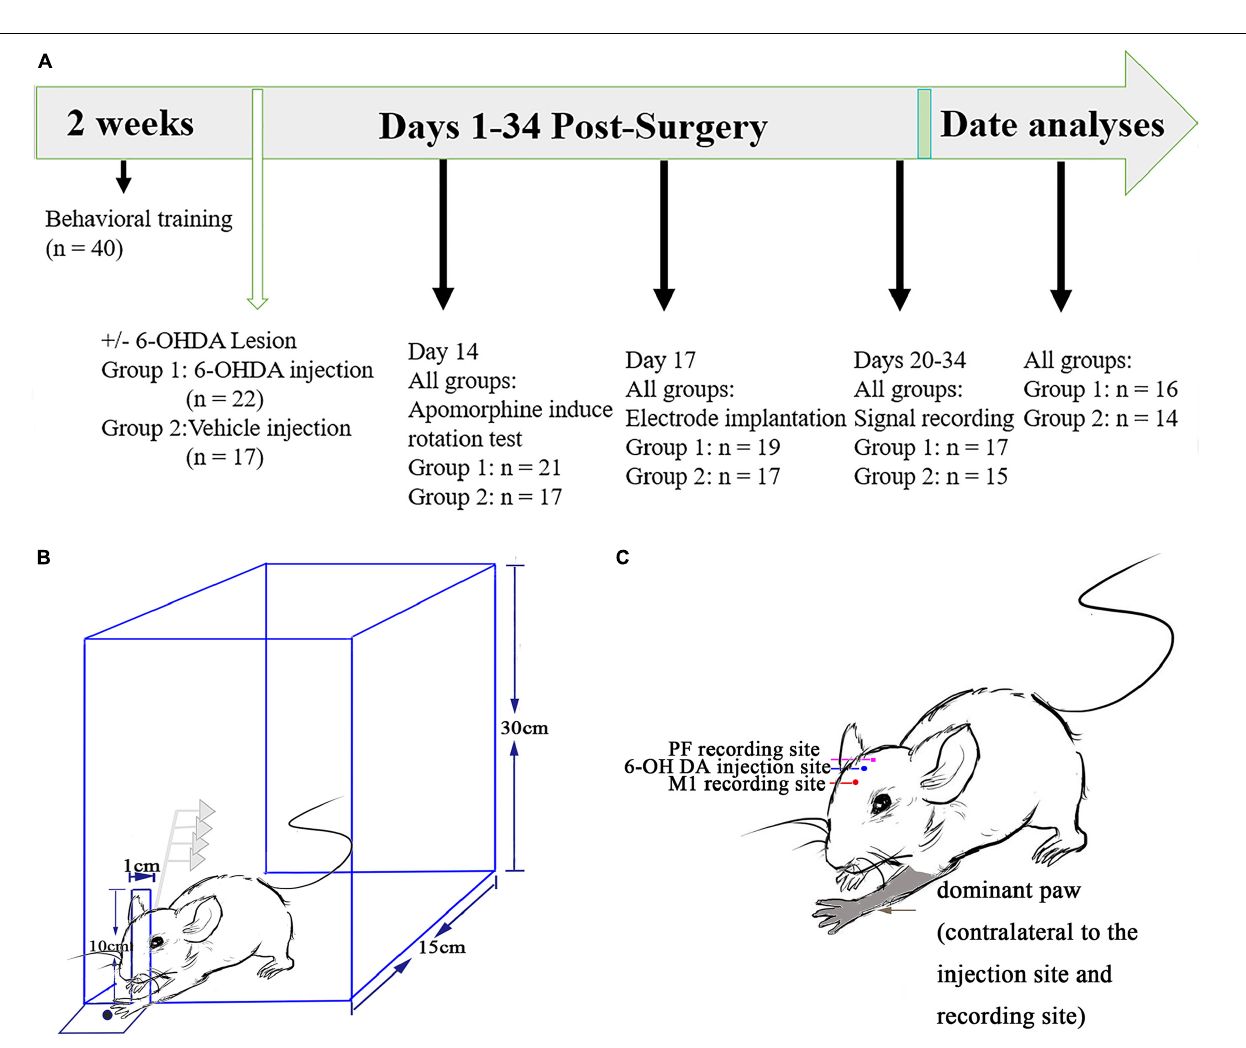
FIGURE 1 | Experimental design and timeline. (A) Prior to and following surgery to induce a unilateral 6-hydroxydopamine (6-OHDA) lesion of the medial forebrain bundle, all rats ( n = 40) underwent behavioral training and were monitored to execute the catching task to obtain food through a slit using their preferred forepaws. All the rats performed an apomorphine-induced rotation test 2 weeks after the surgery. A multiunit recording electrode was implanted into the primary motor cortex (M1) and thalamic parafascicular nucleus (PF) of all the lesioned and control rats 2 weeks after the first surgery. Signal recording began from 20 to 34 days after surgery for further data analyses. (B) Schematic diagram of the multiunit recordings from the M1 and PF nucleus. Slits in the wall of the test chamber were placed individually at the contralateral side of the preferred forepaws. This experiment provides an example indicating that a rat could catch food through a slot with its left forepaw. (C) Illustration showing a rat whose left forepaw dominates after behavioral training. Recording electrodes (M1 and PF) and intracerebral injection of 6-OHDA (or vehicle in the control group) are contralateral to the preferred